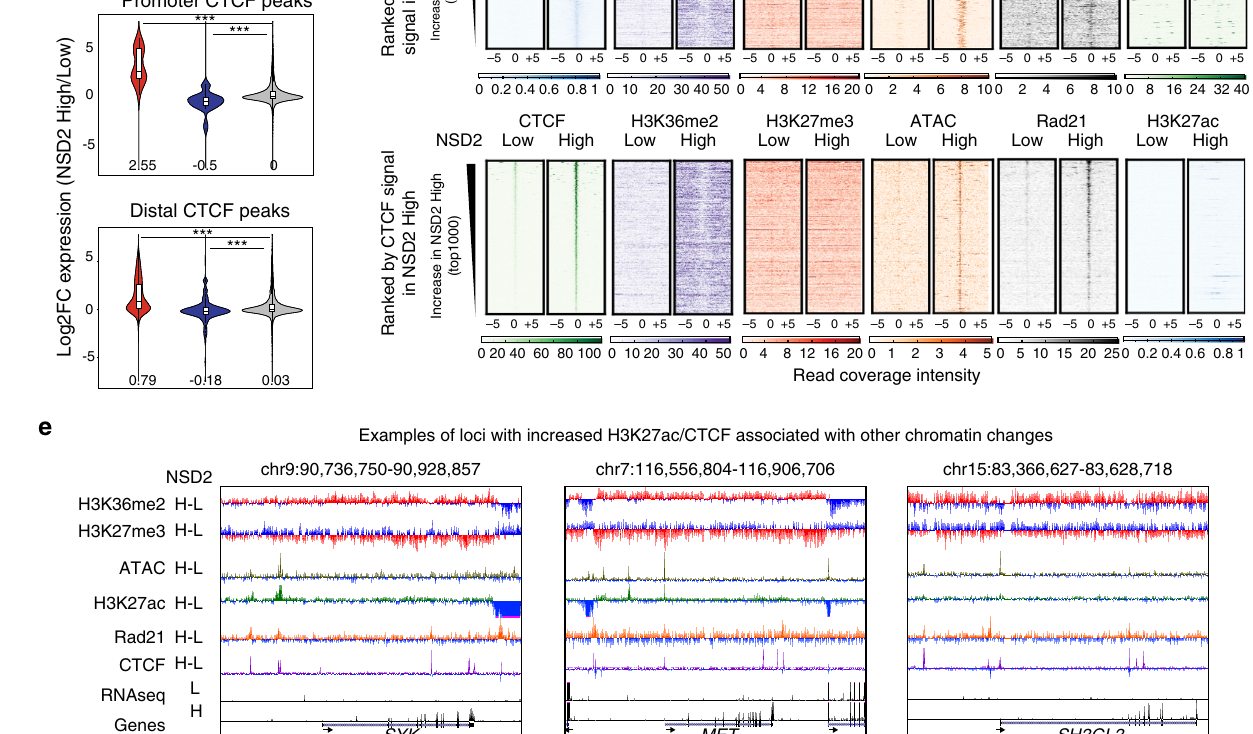
NATURE COMMUNICATIONS| (2019) 10:4843